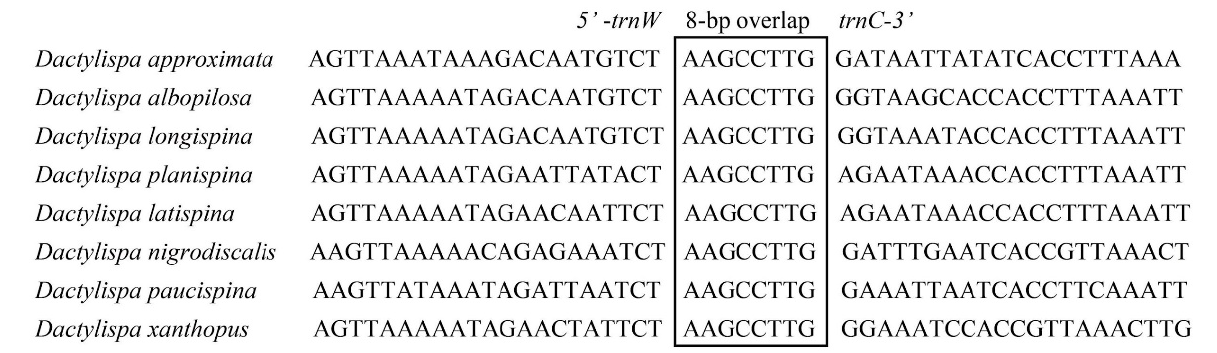
Figure 4. Sequence alignments of trnW/trnC of eight Dactylispa beetles. The boxed nucleotides are the eight-base pair conserved overlaps.